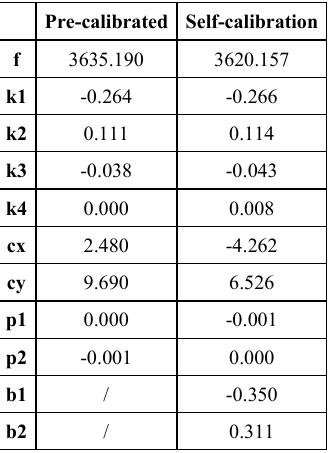
Table 1 I.O. parameters derived from the calibration certificate provided by DJI (left) and parameters estimated through a self- calibration approach (right) Except for the presence of b1 and b2 parameters (affinity or skew), the differences between the other parameters are quite limited. However, the impact of these small differences on the accuracy of the final photogrammetric model must not be underestimated. In Table 2 the RMSe values of the same set